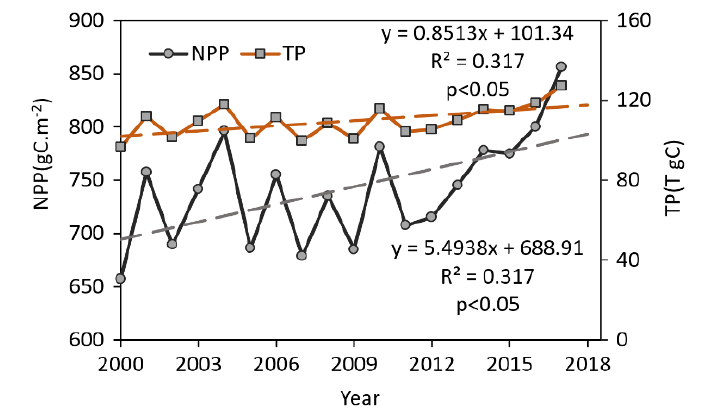
Figure 3. Variations of annual net primary productivity (NPP) and total production (TP) of the Poyang Lake basin during 2000–2017.